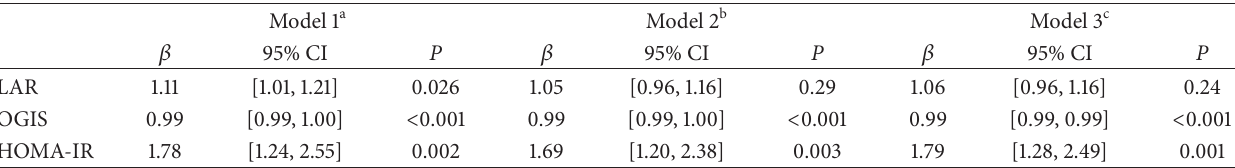
Table 3: Associations between measures of insulin sensitivity and intrahepatic lipid before and after adjusting for NEFA suppression at 30 and